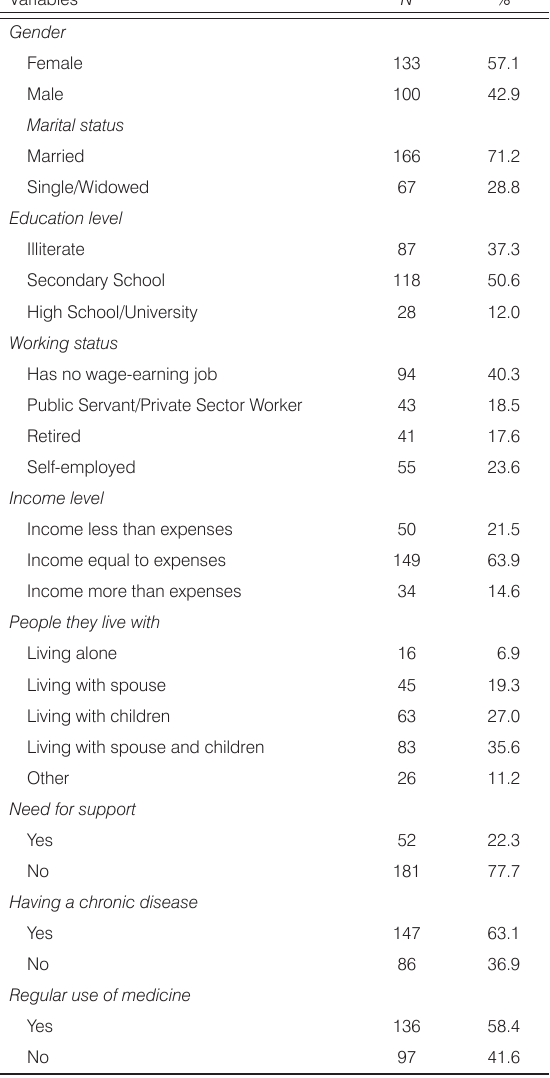
Table 1. Socio-demographic features of the participants ( n = 233).